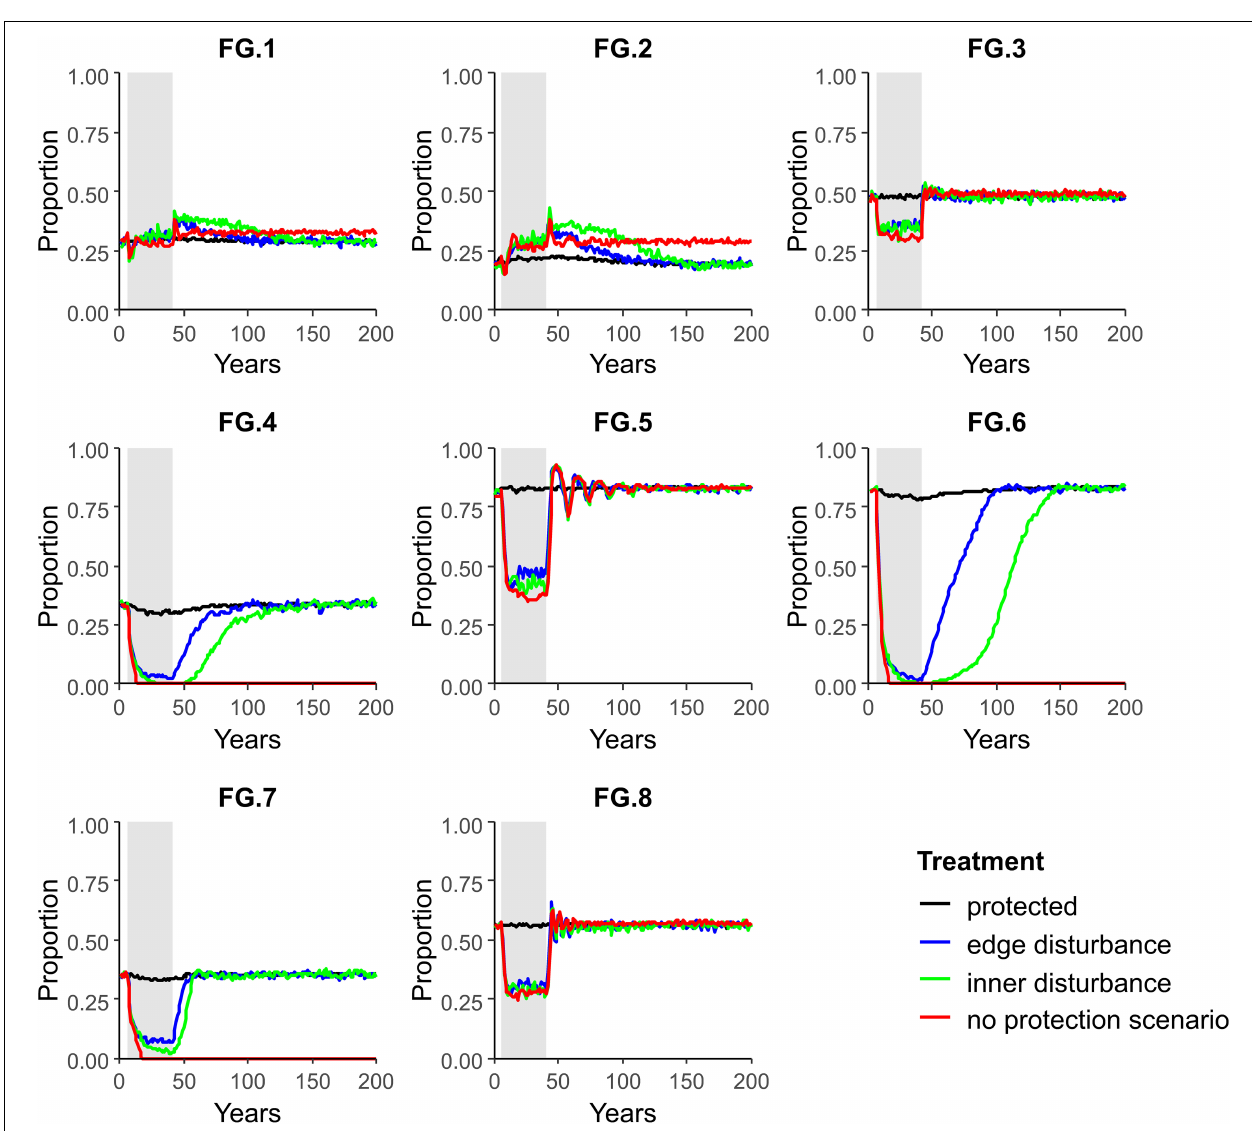
within the model seascape for all other scenarios are presented in the Supplementary Material